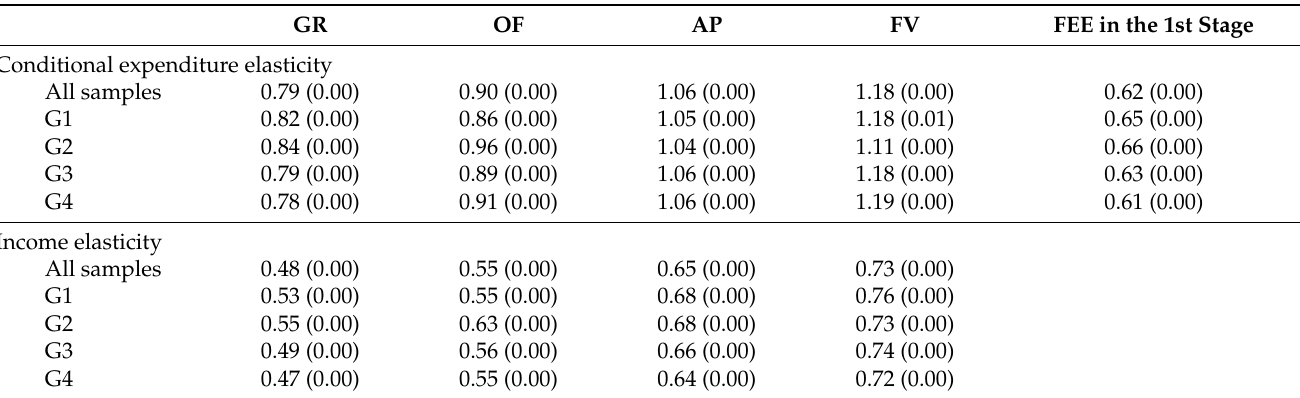
Table 1. Estimated conditional expenditure elasticity and income elasticity.